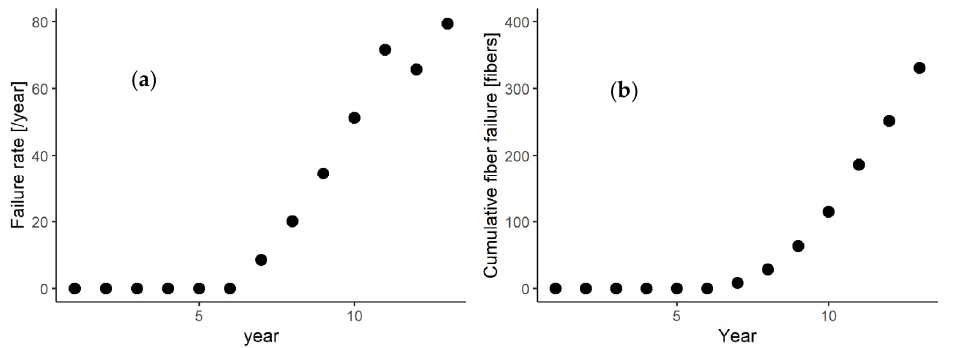
Figure 1. ( a ) Failure rate per year and ( b ) cumulative fiber failure of the plant.